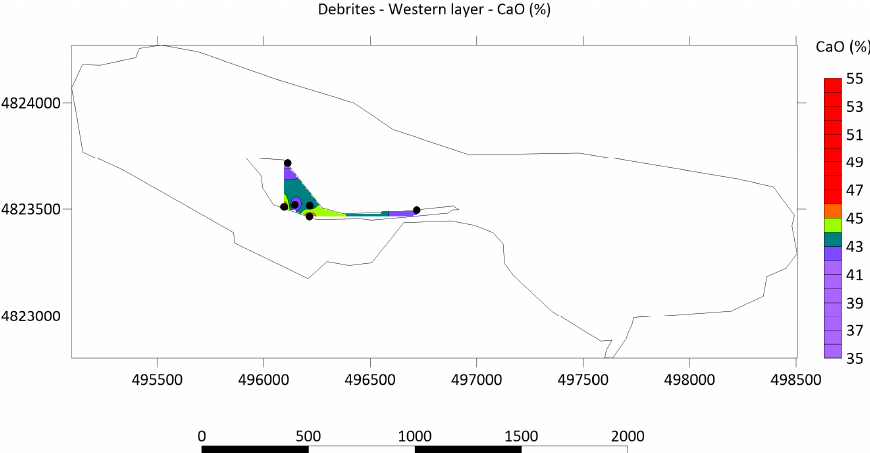
Figure 15. Map of CaO (%) in unit (7), western layer (boreholes are black Figure 15 . Map of CaO (%) in unit (7), western layer (boreholes are black dots).